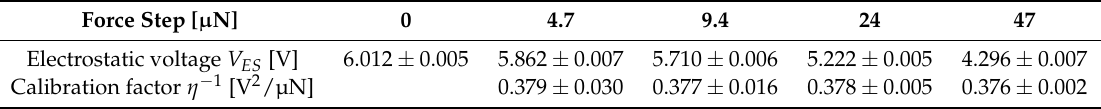
Table 1. Calculation of the force calibration factor from the simulated force-dependent electrostatic